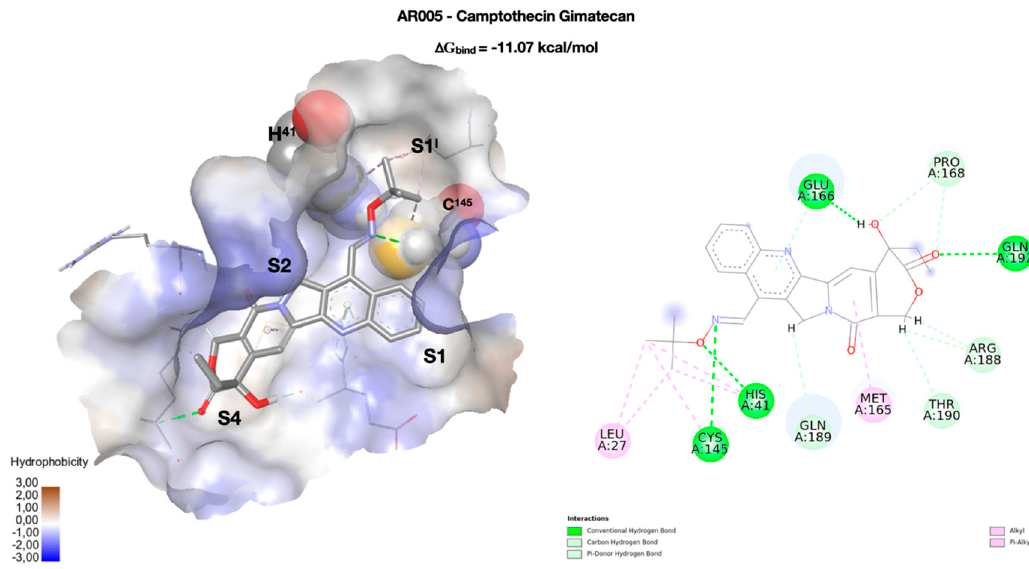
Figure 2. Docking pose of the camptothecin derivative gimatecan (AR005). On the left, the conformation of the ligand (in stick) inside the enzymatic binding site, represented as solvent accessible surface (SAS) and colored according to the hydrophobicity of the residues (in wireframe). The two key residues of the catalytic dyad (H 41 and C 145 ) are rendered in CPK. The four binding pockets (S1 I , S1, S2, and S4) occupied by the molecule are highlighted. On the right, a two-dimensional representation of the molecular interactions between the ligand and the enzyme. Here, the colors used refer to the di ff erent interactions, as indicated in the legend.